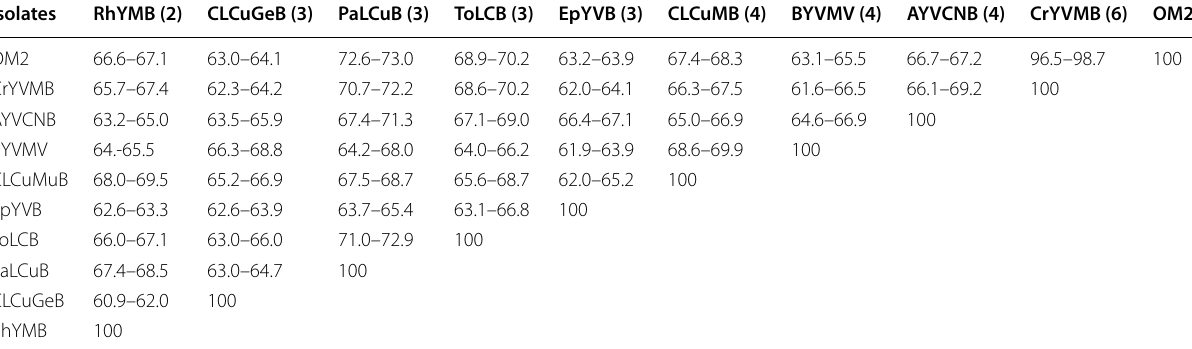
Sequences were selected of the most similar species from the blast comparison